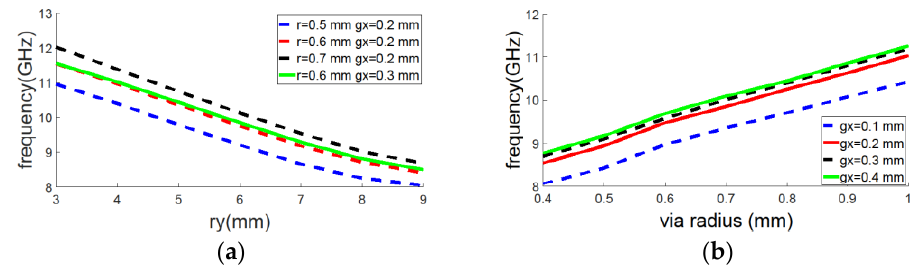
Figure 8. Resonant frequency for the EBG resonator loading the line as a function of: ( a ) resonator length (ry) (for differents radius (r) and for two gap values with rx = 5 mm) ( b ) via radius (r) (for differents gaps with the line (gx) and rx = 5 mm).